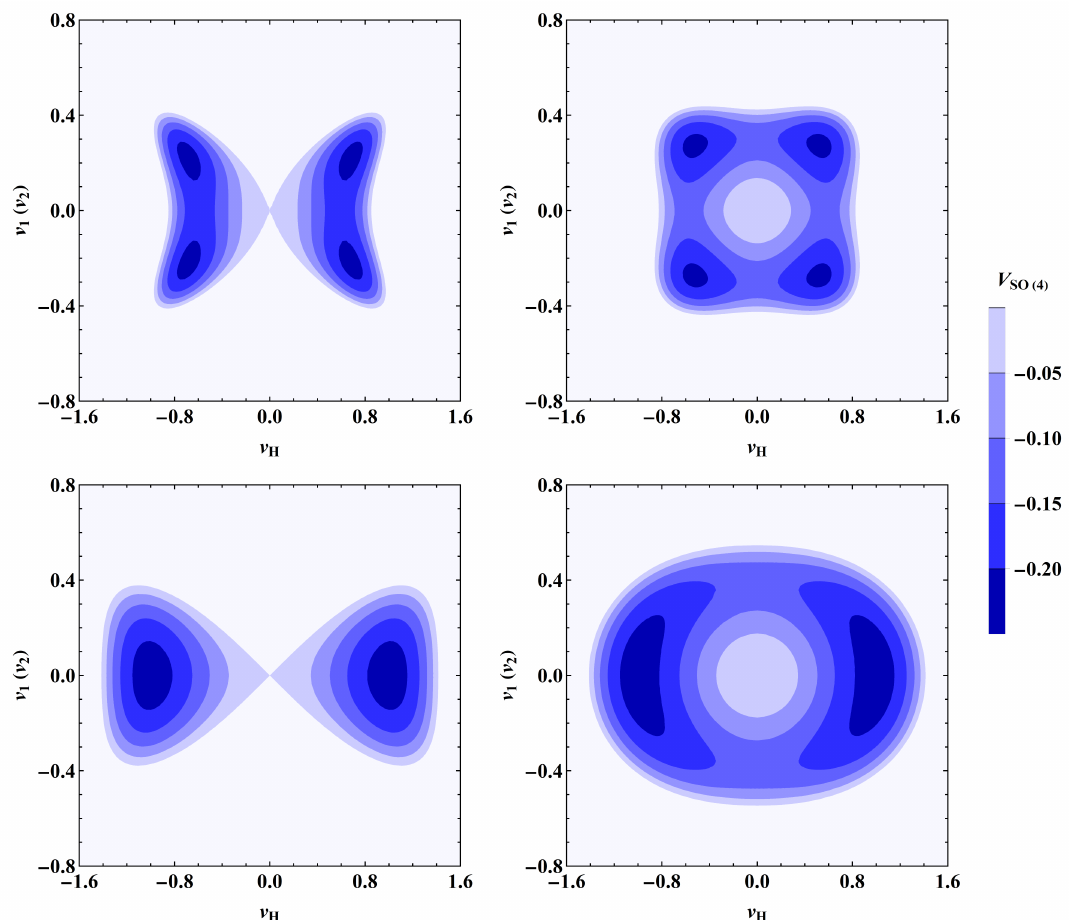
with respect to the vacuum expectation values v , v and Figure 1 . The distributions of V 1 H SO(4) in four different cases with some typical parameters. Top-left panel: µ 2 = 1 . 99 , m 2 = 0 . 33 , v 2 11 H = 5 . 48 , λ = 5 . 48 , λ = − 6 . 03 ; Top-right panel: µ 2 = 1 . 41 , m 2 = − 1 . 49 , λ = 4 . 12 , λ = 4 . 12 , λ 1 14 11 1 H H H = 1 . 65 ; Bottom-left panel: µ 2 = 0 . 90 , m 2 = 0 . 90 , λ = 0 . 90 , λ = 0 . 90 , λ = − 0 . 68 ; Bottom- λ 14 11 1 14 H H = 0 . 90 , m 2 = − 0 . 90 , λ = 0 . 90 , λ = 1 . 49 , λ = 2 . 09 . For illustration, all the right panel: µ 2 11 1 14 H H mass-dimensional parameters have been properly normalized to be dimensionless. Furthermore, v 1 and v are assumed to be equal to each 2